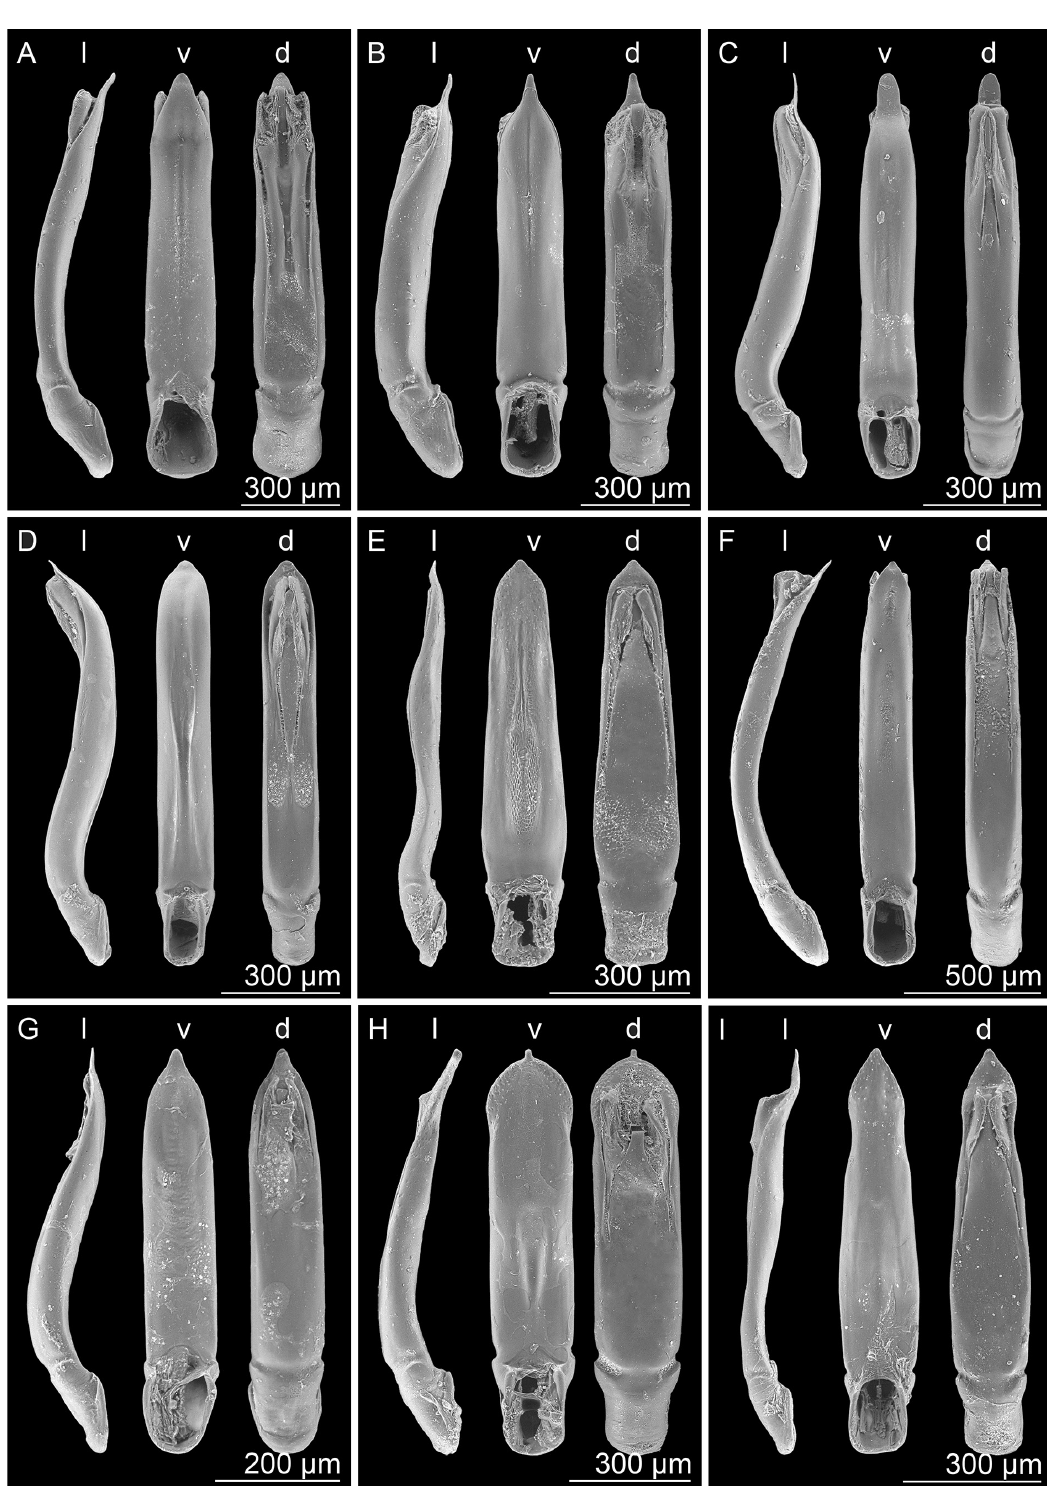
Fig. 8. Median lobe of aedeagus in lateral (l), ventral (v) and dorsal (d) view. A–B . Arsipoda